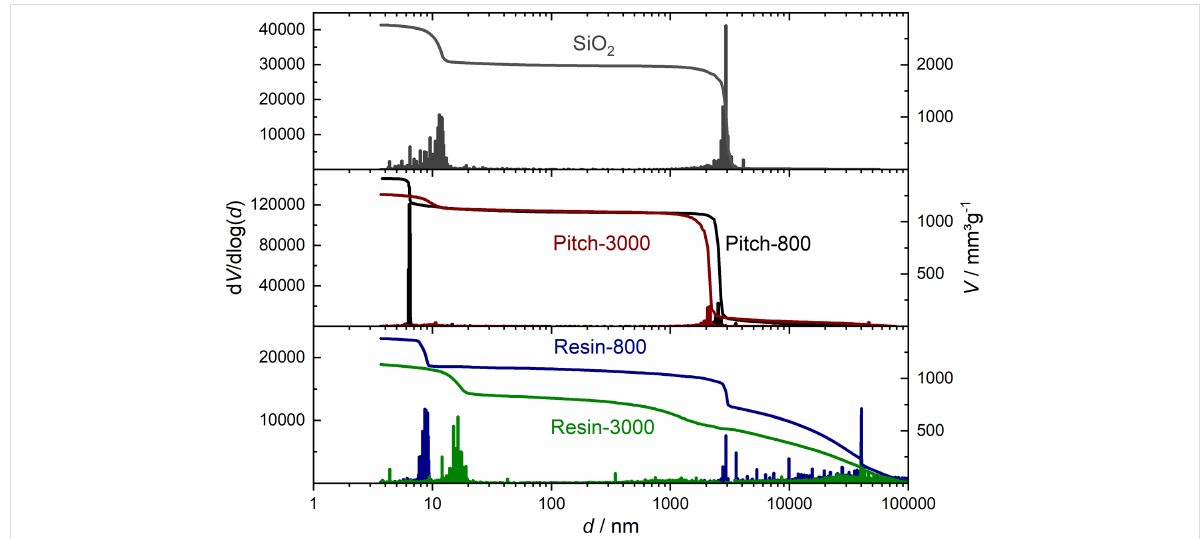
Figure 2: Mercury intrusion porosimetry (MIP) data of the pristine meso-macroporous SiO 2 monolith (top) and the templated carbon materials, treated at 800 and 3000 °C.